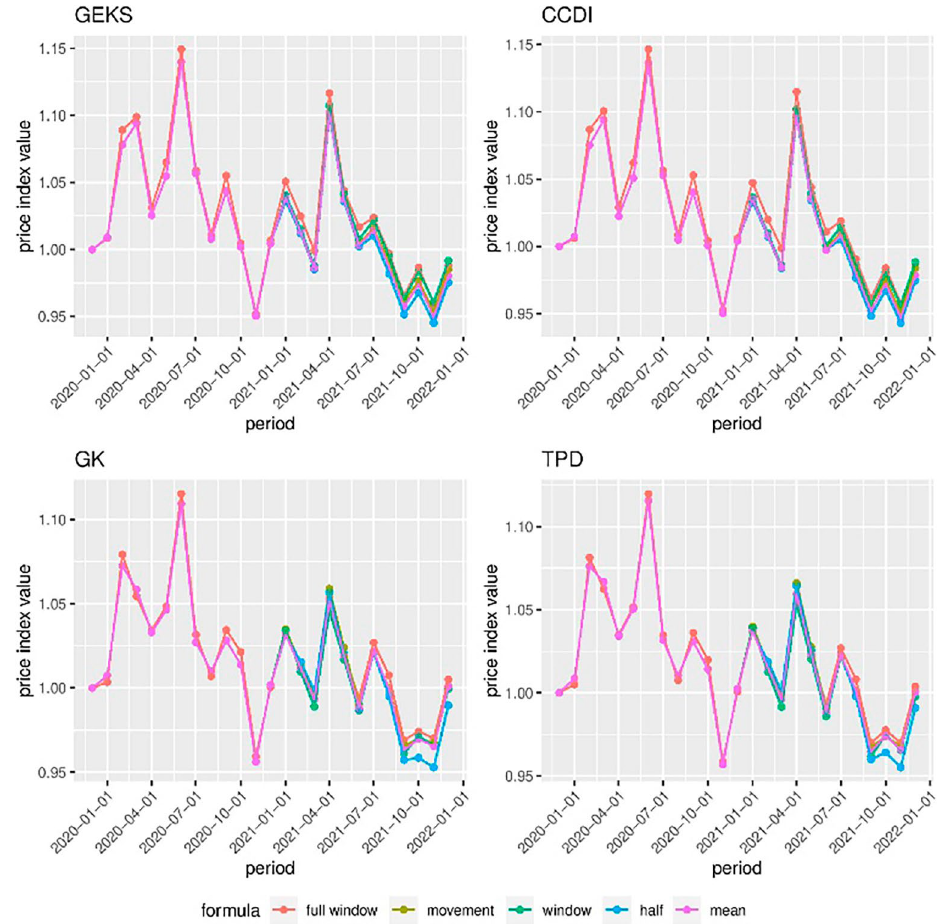
Figure A5. Comparison of c IDT G indices (splicing methods vs full time indices) for coffee